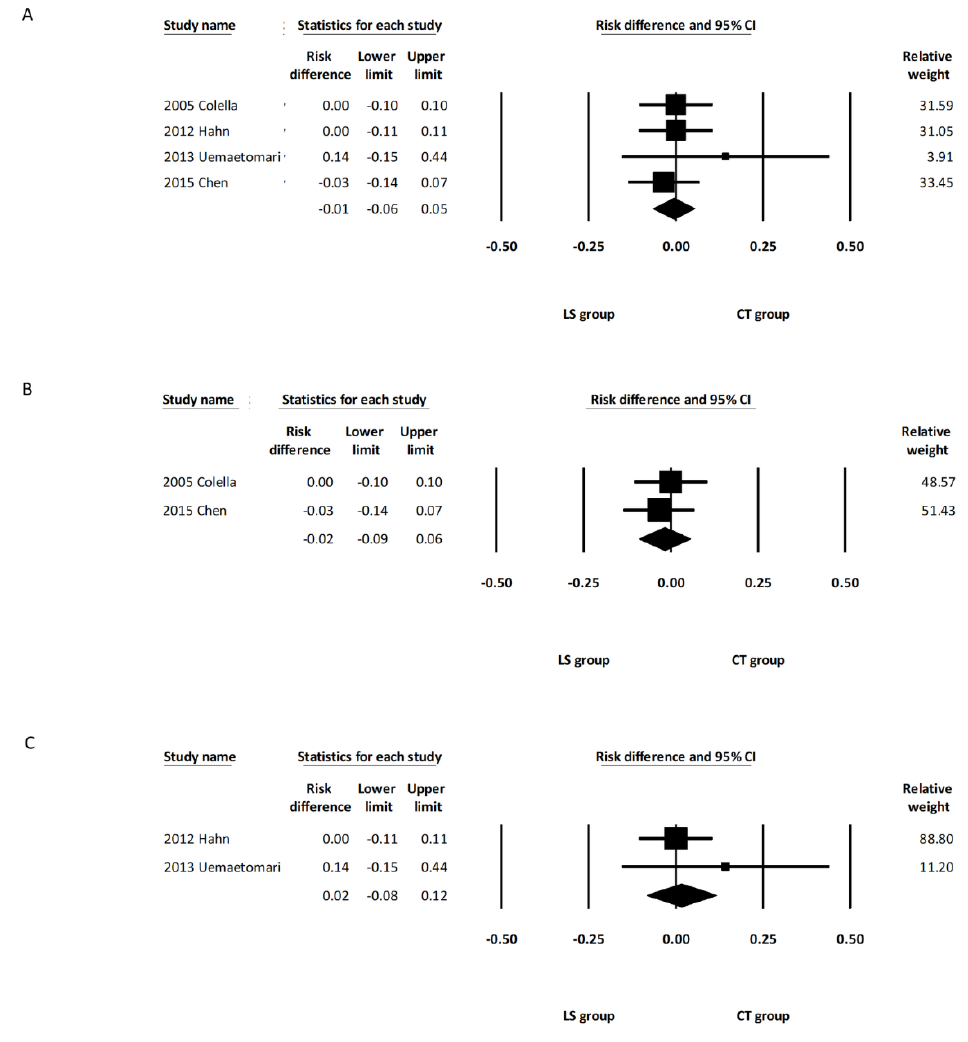
Figure 3. Forest plot of the incidence of permanent facial palsy after parotidectomy. ( A ) Overall study group. ( B ) Studies including only the LSP device. ( C ) Studies including only the LSJ device. LS, LigaSure; LSP, LigaSure Precise; LSJ, LigaSure Small Jaw; CT, conventional technique; CI, confidence